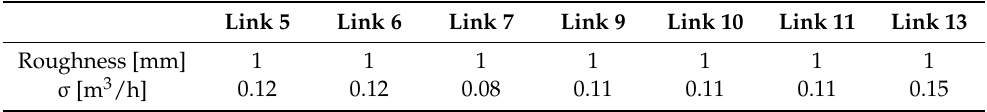
Table 2. Standard deviation between the pressures measured in the network and simulated numeri- cally. Node 6 Node 7 Node 9 Node 10 σ [mH 2 O] 0.01 0.15 0.05 0.09 Table 3. Pipes roughness and standard deviation between the flow rates measured in the network and simulated numerically. Link 5 Link 6 Link 7 Link 9